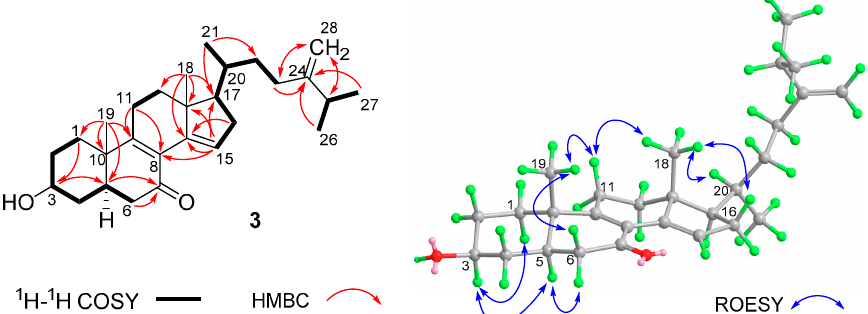
Figure 5. The 1 H– 1 H COSY and key HMBC and ROESY correlations of 3 .